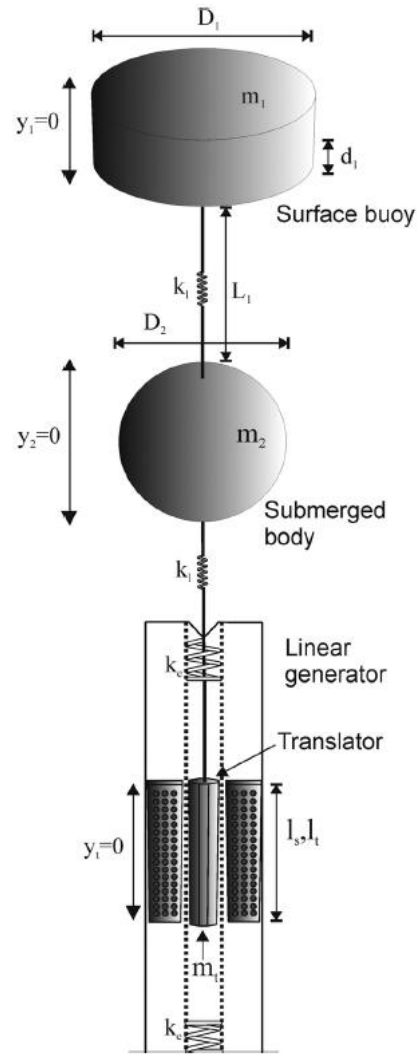
Figure 12. Conceptual sketch of a 2 degrees of freedom direct drive WEC [27] .